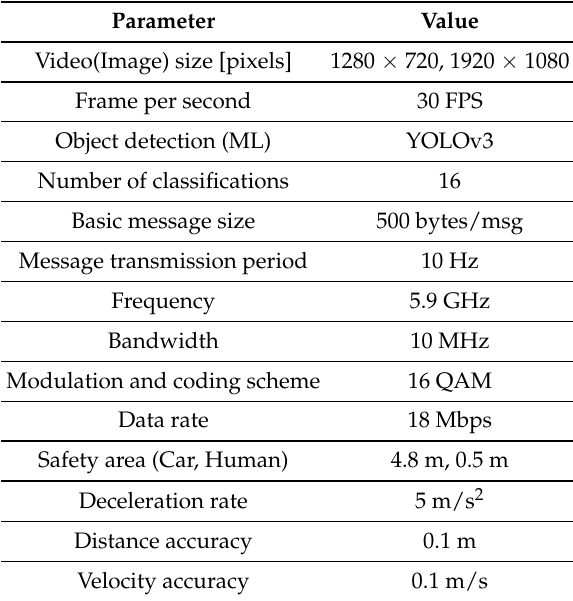
Table 2. Experimental parameters.